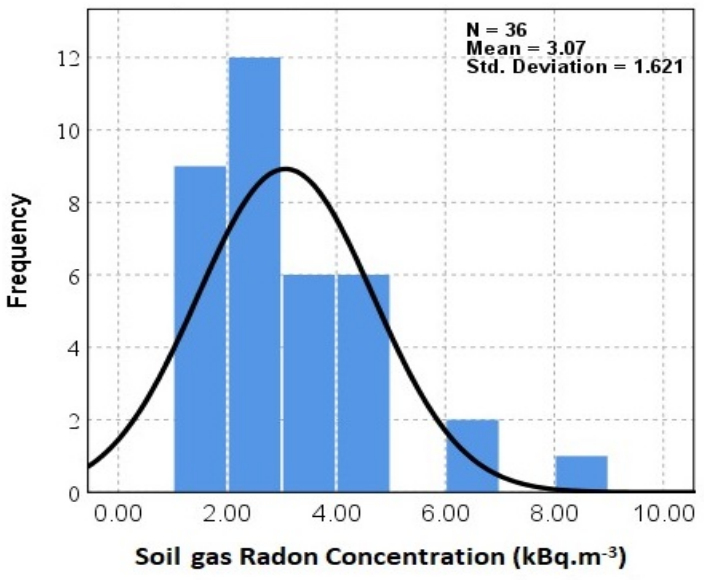
Figure 5. The soil-gas radon concentrations (kBq m − 3 ) in the studied area.